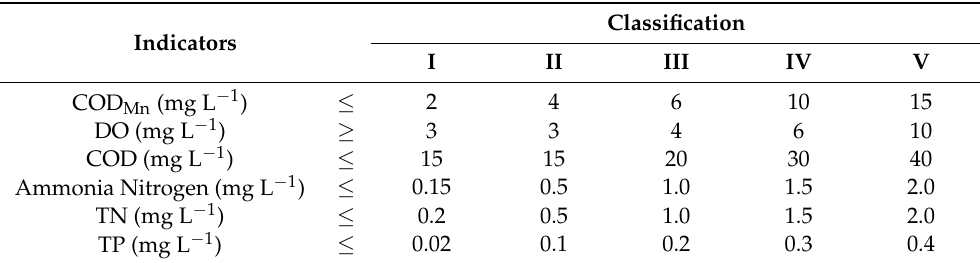
Table 1. Surface water classification standards of China (GB3838-2002).